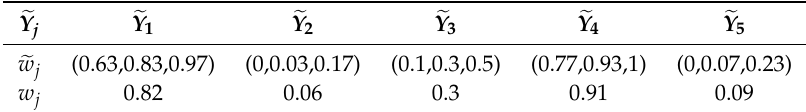
Table 14. New fuzzy and defuzzified